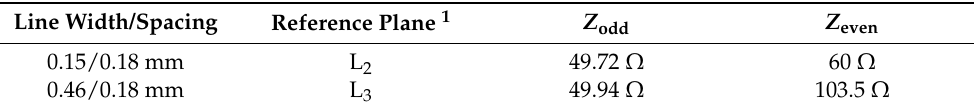
Figure 6. ( a ) The stack of PCB board; ( b ) Top view of the proposed design; ( c ) Bottom view of the proposed design of an RC-tank Unified Circuit; ( d ) Bottom view of the proposed design of an RC- branch Unified Circuit. Table 1. Characteristic Impedance of Practical Structure. Table 1. Characteristic Impedance of Practical Structure.